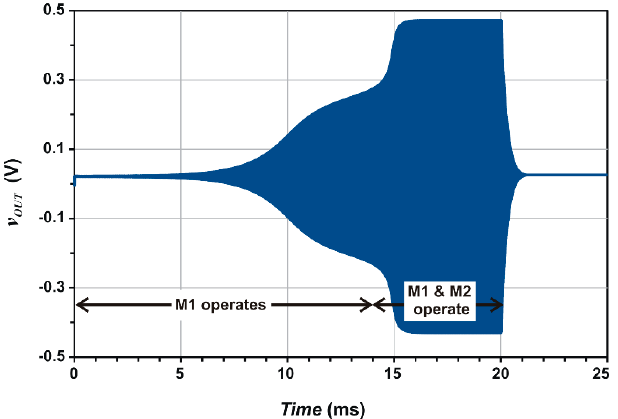
Figure 9. The output voltage, v OUT , waveform in HSCO illustrating the startup process. The voltage waveform at the output of the starter, v ST , is shown in Figure 10. It can be seen that obtaining v ST above 1 V became possible only after boosting the oscillator by the transistor M 1a . The effectiveness of the shutdown circuit can be determined based on the waveform of the current i SUP sourced from the supply V DD . In shutdown state, i SUP de ‐ creases to a few tens of nA.